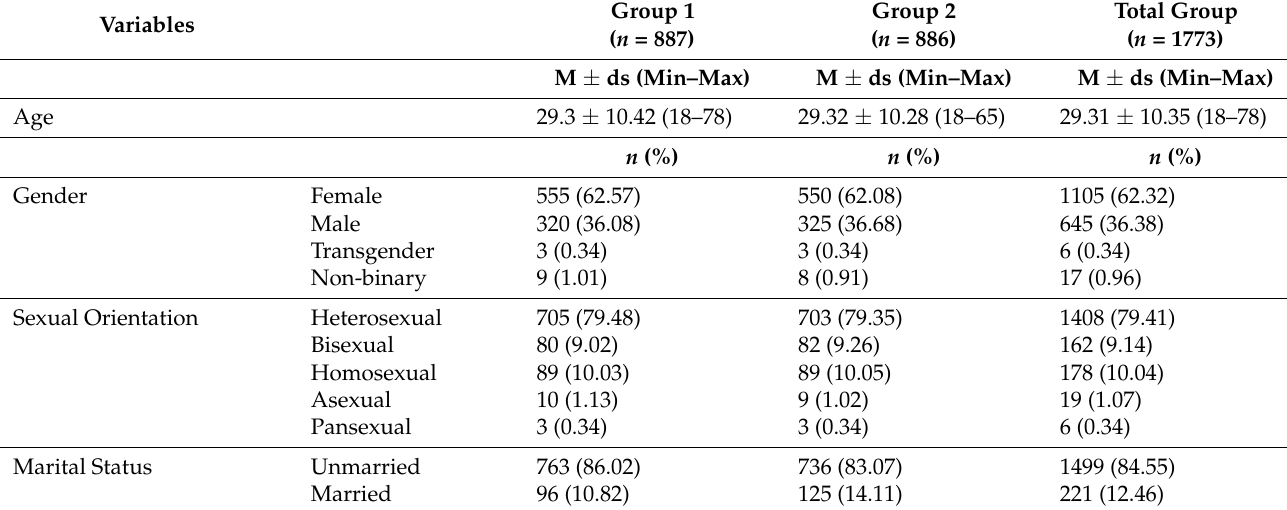
Table 1. Sociodemographic variables